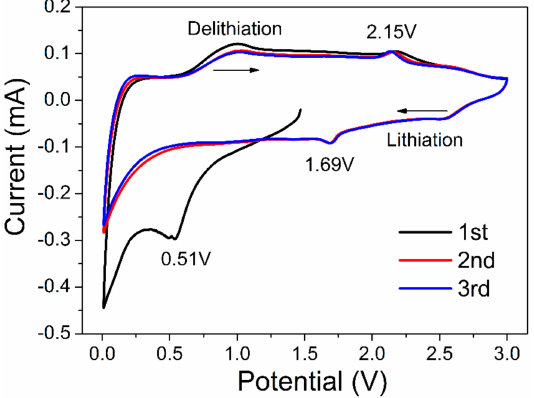
Figure 8. Cyclic voltammetry (CV) curves of the RGO/Ti 3 C 2 T x nanocomposite from 3.0 to 0.01 V at a scan rate of 0.2